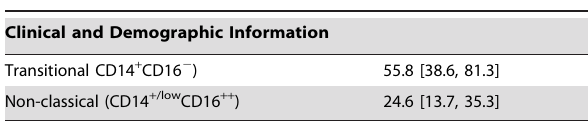
Table 1. Baseline characteristics of the subjects. Table 1.